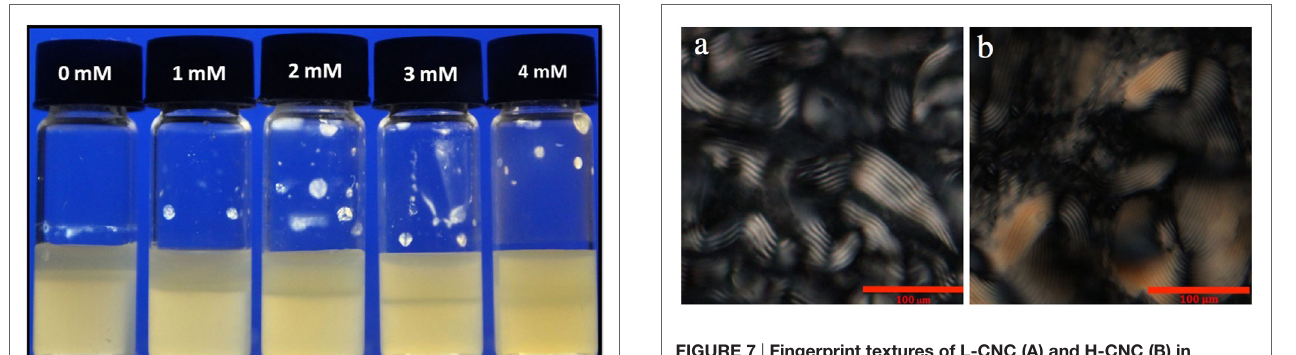
FigUre 7 | Fingerprint textures of l-cnc (a) and h-cnc (B) in deionized water at w = 10 wt.-% . From the images, pitch values of about 10 and 8 μ m, respectively, can be estimated for the two CNC types.